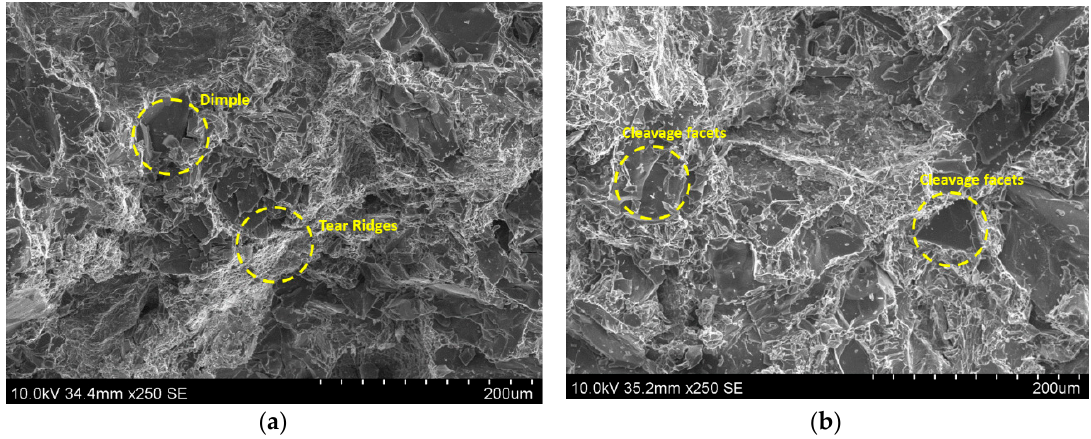
Figure 9. SEM photomicrographs of ( a ) gravity die cast A390 alloy showing many dimples and tear ridges and ( b ) squeeze die cast A390 alloy showing many cleavage surfaces and fewer tear ridges.